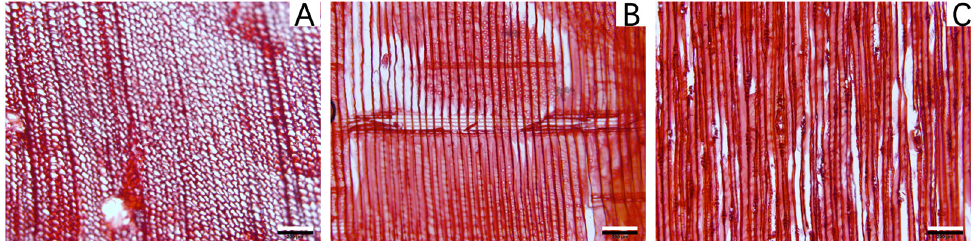
Figure 1. Morphological structure of the wooden Baotou beam: ( A ) cross-section, ( B ) radial section, and ( C ) tangential section. Scale bars = 200 μ m.